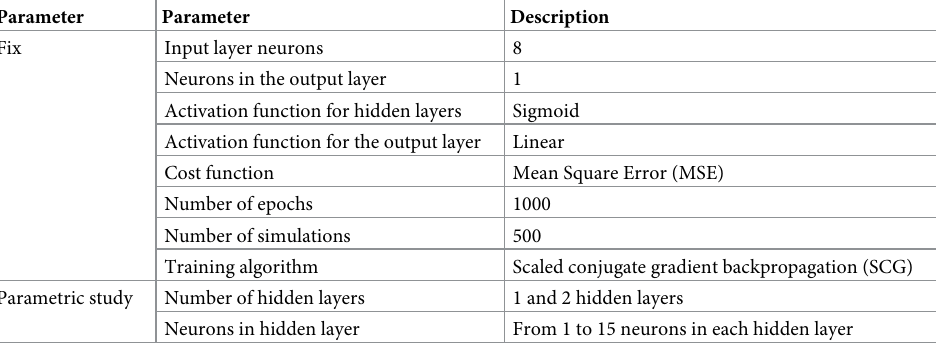
Table 3. Summary of different ANN characteristics and investigation parameters in this